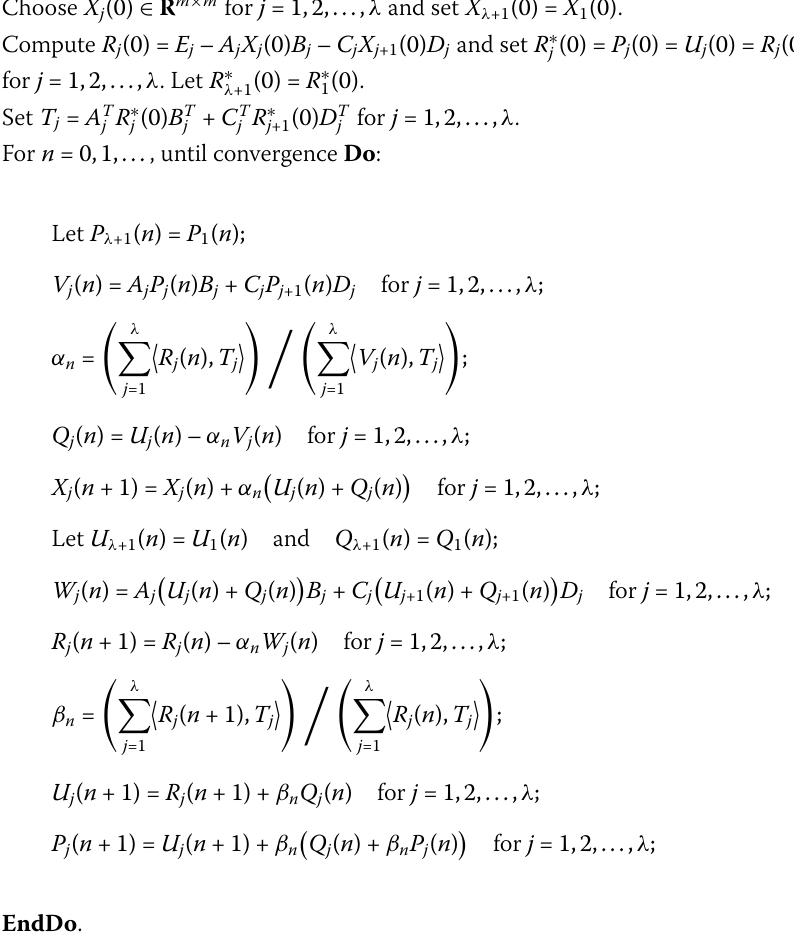
Algorithm 2.6 (Matrix CRS2 method for solving